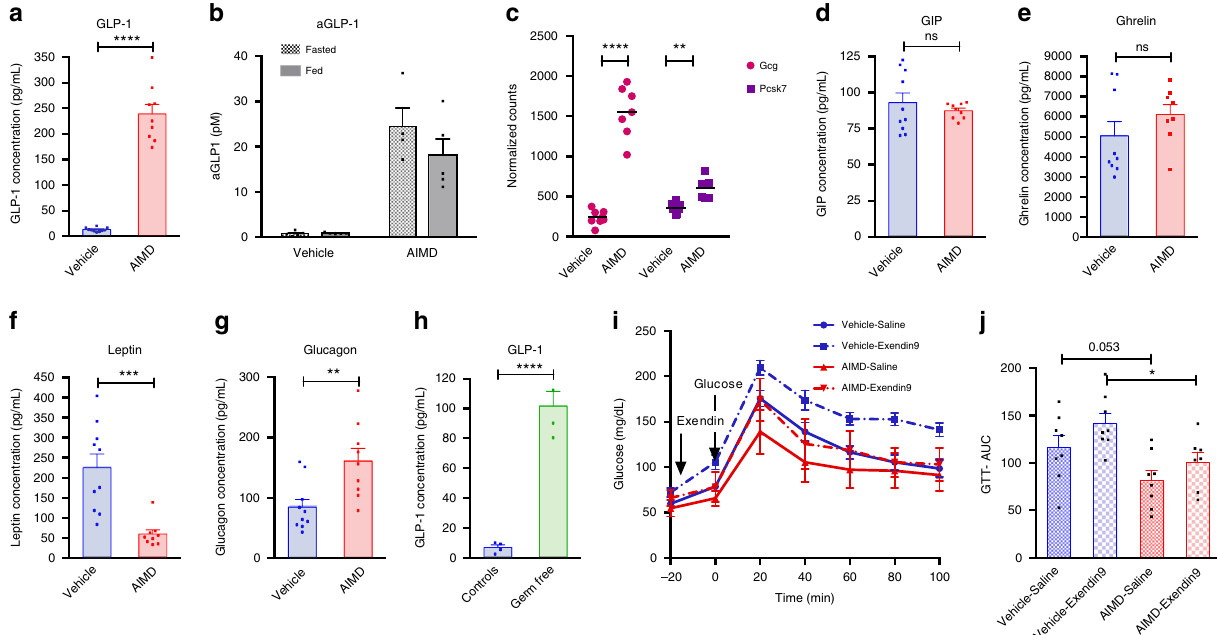
Fig. 4 AIMD increases GLP-1 and affects other gut hormones. a Fasting serum level of total GLP-1 ( n = 9 – 10/group). b Serum level of active GLP-1 after 16 h of fasting (fasted) or 15 min after an oral bolus of glucose (1 g/kg BW; fed). Blood was collected on Ddp4 inhibitor-coated tubes ( n = 5/group). c Quanti fi cation by RNA-sequencing of Ggc and Pcsk7 mRNA expression in the cecum ( n = 7 – 8/group). Adjusted p value from negative binomial Wald test (corrected for multiple hypothesis testing with the Benjamini – Hochberg method), * p < 0.05, ** p < 0.01, *** p < 0.001, **** p < 0.0001. d – g Serum endocrine panel — plasmatic levels of GIP ( d ), ghrelin ( e ), leptin ( f ), and glucagon ( g ) ( n = 9 – 10/group). h Serum level of total GLP-1 in GF mice ( n = 4/ group). i , j AIMD or vehicle mice were IP injected Exendin-9 (250 nmol/kg) or saline 20 min prior to receiving an oral bolus of glucose (1 g/kg BW) and glucose concentration was monitored over 100 min ( n = 8/group). Quanti fi cation of the area under the curve (AUC, j ). Serum collection and oGTT were performed at 1 week after intervention. Unless otherwise stated, Student ’ s t test, * p < 0.05, ** p < 0.01, *** p < 0.001, **** p < 0.0001, ns nonsigni fi cant.